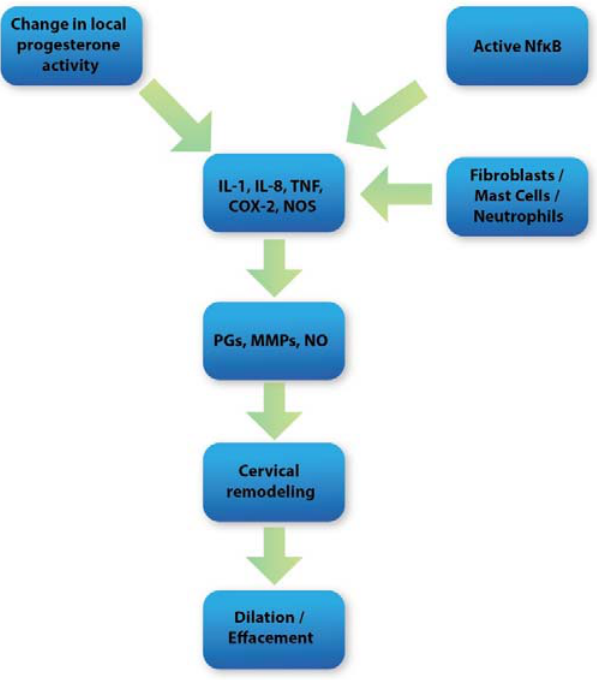
Figure 1. Diagram showing overall molecular mechanisms during cervical